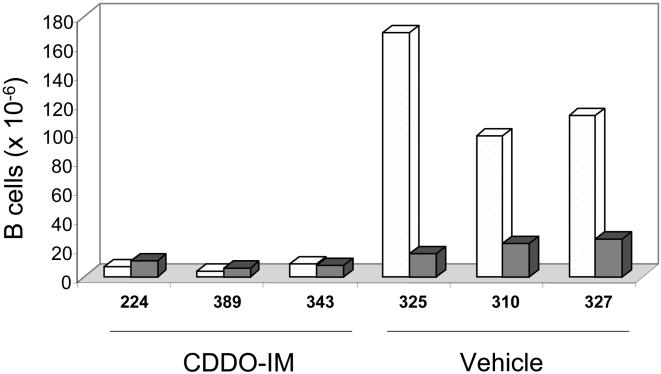
Determination of the total number of normal B lymphocytes and CLL/SBL cells in spleen of mice treated with empty liposomes or with CDDO-Im containing liposomes.The total number of B lymphocytes (CD45+/B220+) in spleen was quantified using a cell analysis and microfluorocytometer (Guava technologies). The percentages of the B220H FSCL normal B cells and of the B220M FSCM CLL/SBL cells were assessed by FACS (see Figure 6). The total number of CLL/SBL cells (white) and normal B lymphocytes (grey) in 3 mice treated with 10 mg/Kg CDDO-Im and 3 mice treated with empty liposomes is shown.